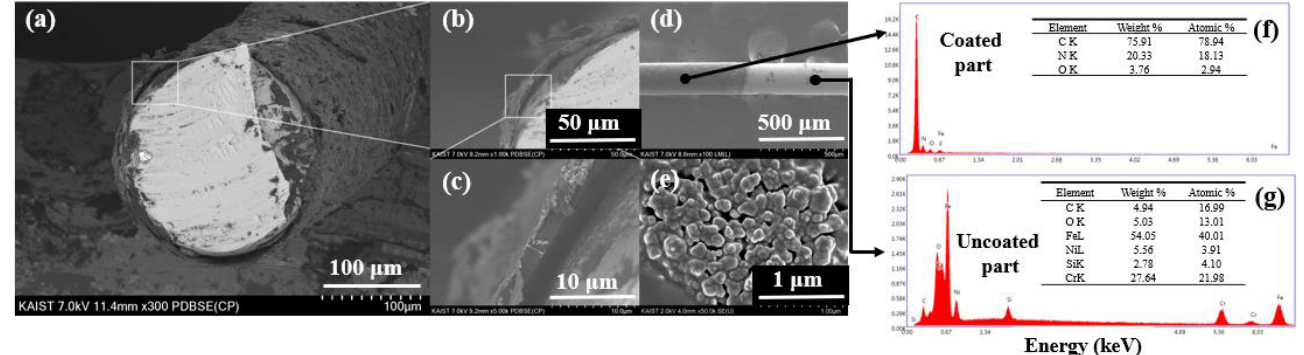
Figure 2. Cross-section SEM images of MWCNT−IL/PANI−coated wire ( a – e ) and EDS spectrum of the coated wire ( f ) and uncoated wire with MWCNT−IL/PANI ( g ).